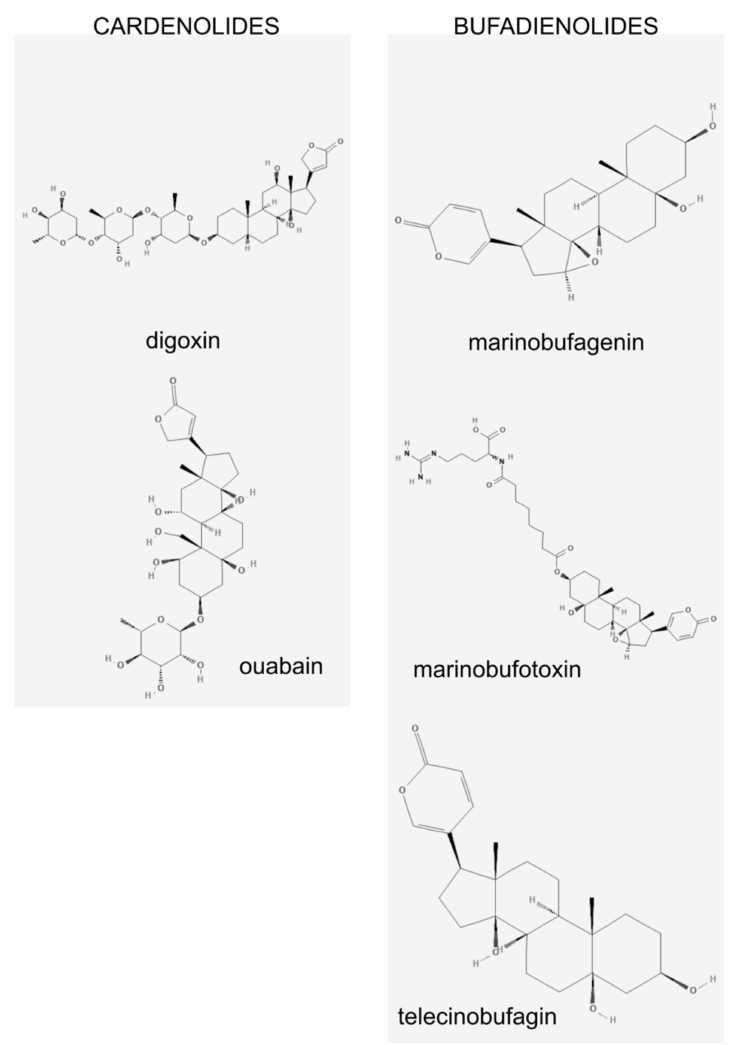
Figure 1. Chemical structure of cardiotonic